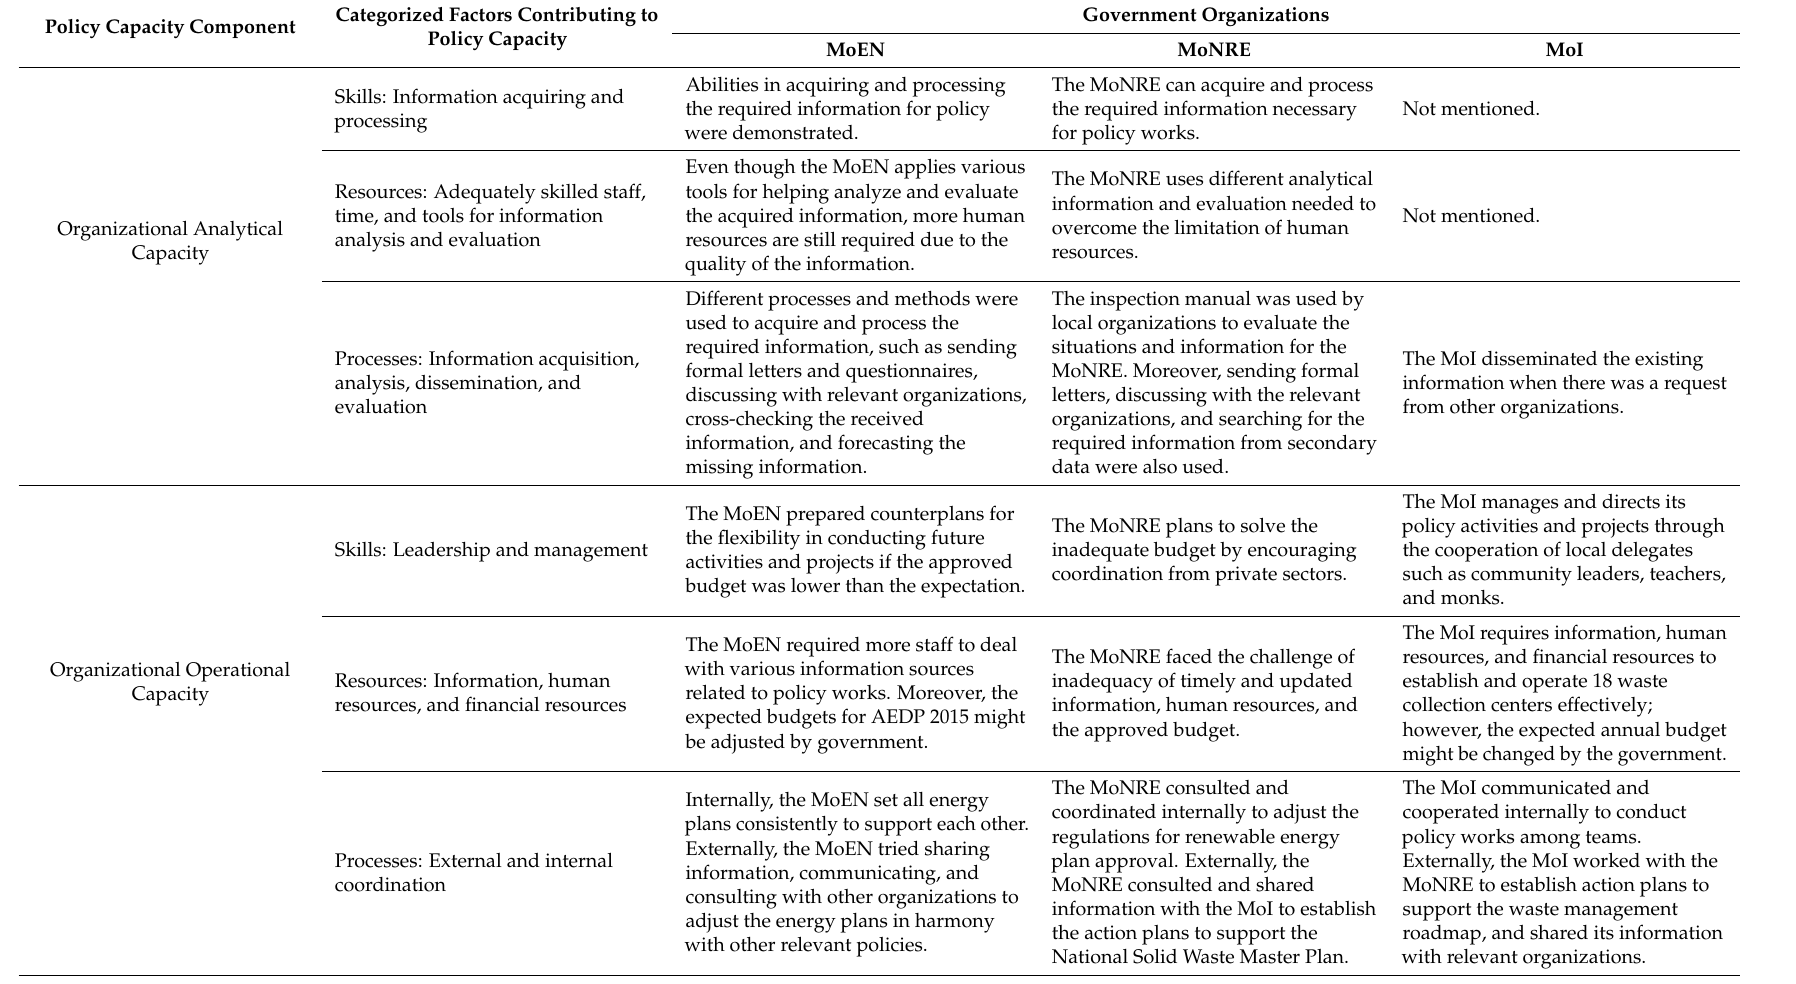
Table 6. The examined policy capacity of government organizations as noted from in-depth